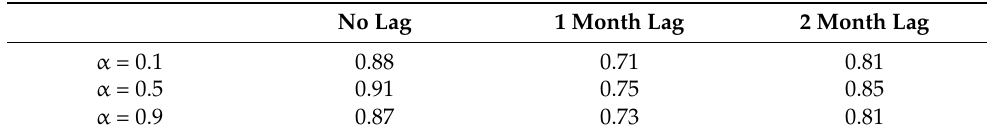
Figure 5. Box plots of smart beta returns for different tilting investment variables (G, L, N), gain threshold values (from top to bottom: 2.5%, 5%, and 7.5%), and values of alpha (from left to right: 0.1, 0.5, 0.9). Source: our elaboration on data. (**) 0.001 < p -value ≤ 0.01; (*) 0.01 < p -value ≤ 0.05. Table 12. Accuracy of LDA